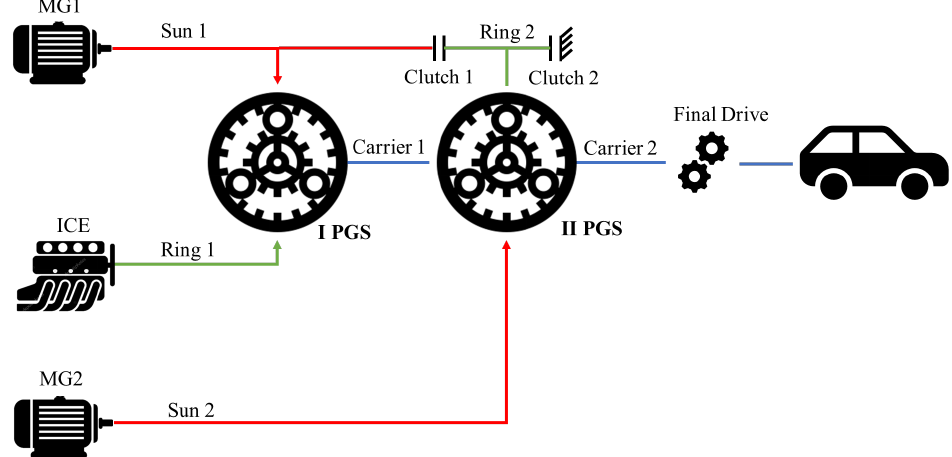
Figure 1. Scheme of the powertrain architecture in the two-mode hybrid system.